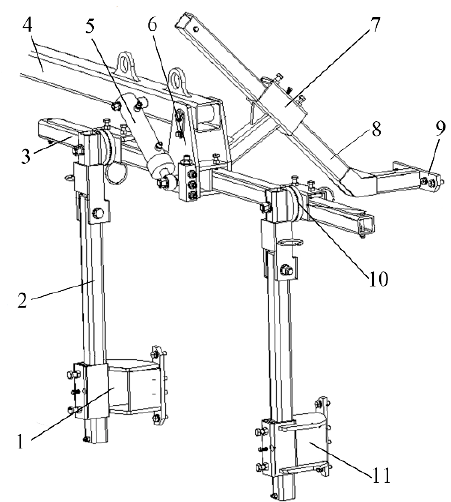
Figure 7. Schematic diagram of shaping and pruning frame structure. (1) Left connecting seat for side pruning assembly. (2) Long vertical beam. (3) Crossbeam for pruning frame. (4) Crossbeam for adjustment frame. (5) Swinging cylinder. (6) Connecting seat for shaping and pruning frame. (7) Fixing sleeve for oblique beam. (8) Top pruning diagonal beam. (9) Connecting seat for top pruning assembly. (10) Fixing sleeve for frame beam. (11) Right connecting seat for side pruning assembly.